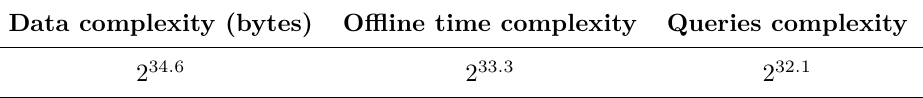
Table 3: AES4 attack complexities.